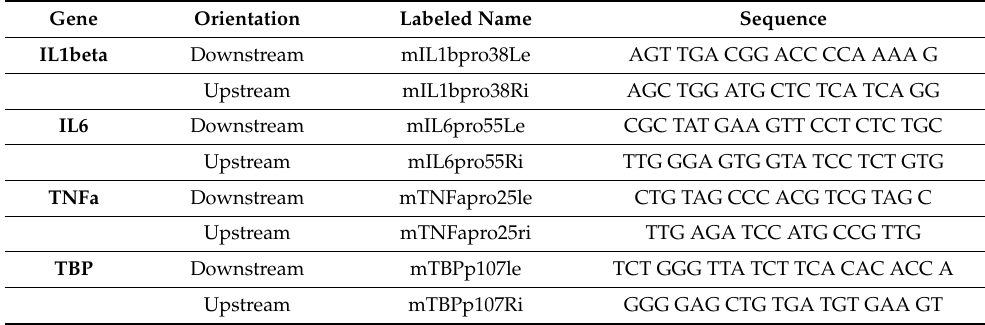
Table 3. Proinflammatory gene expression primers.